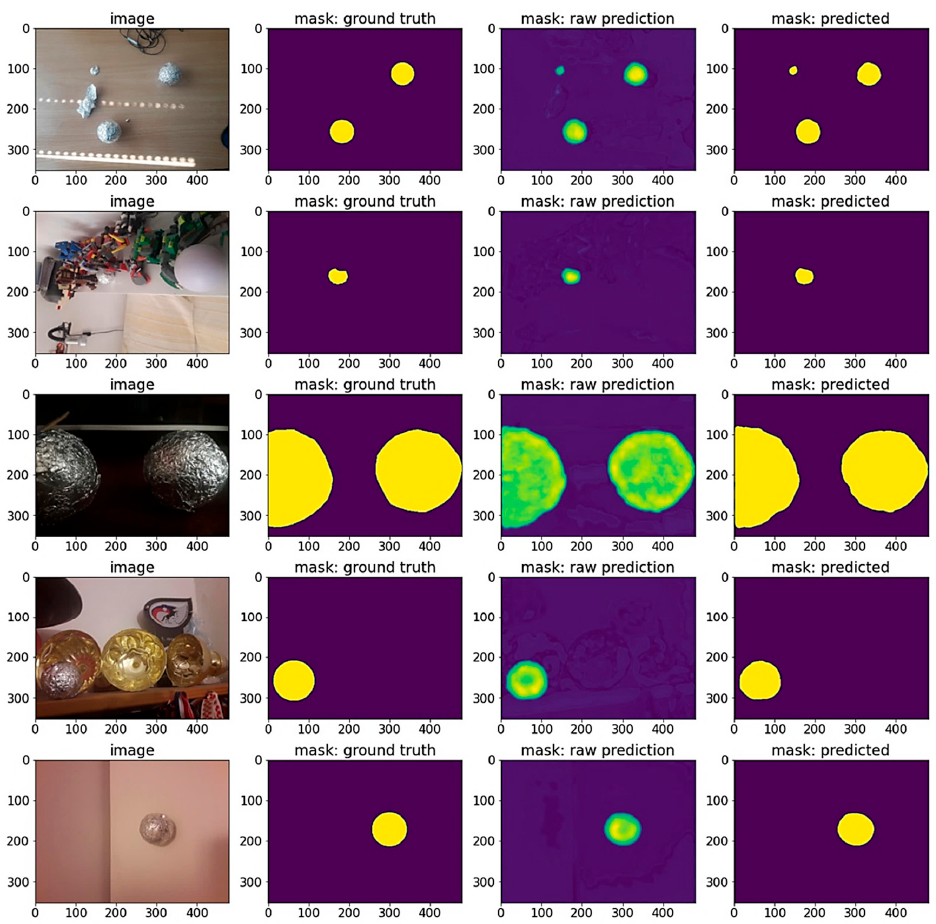
Figure 7. EfficientNet encoder predictions. From left to right: original input image, annotated ground truth mask, raw model’s output prediction and model’s prediction. Mask is represented with yellow color and background with purple color. In the mask: raw prediction column, multiple shades of color correspond to the value of probability at the output of the network: lighter colors correspond to higher probabilities that pixel is part of mask, while darker colors correspond to lower ones.